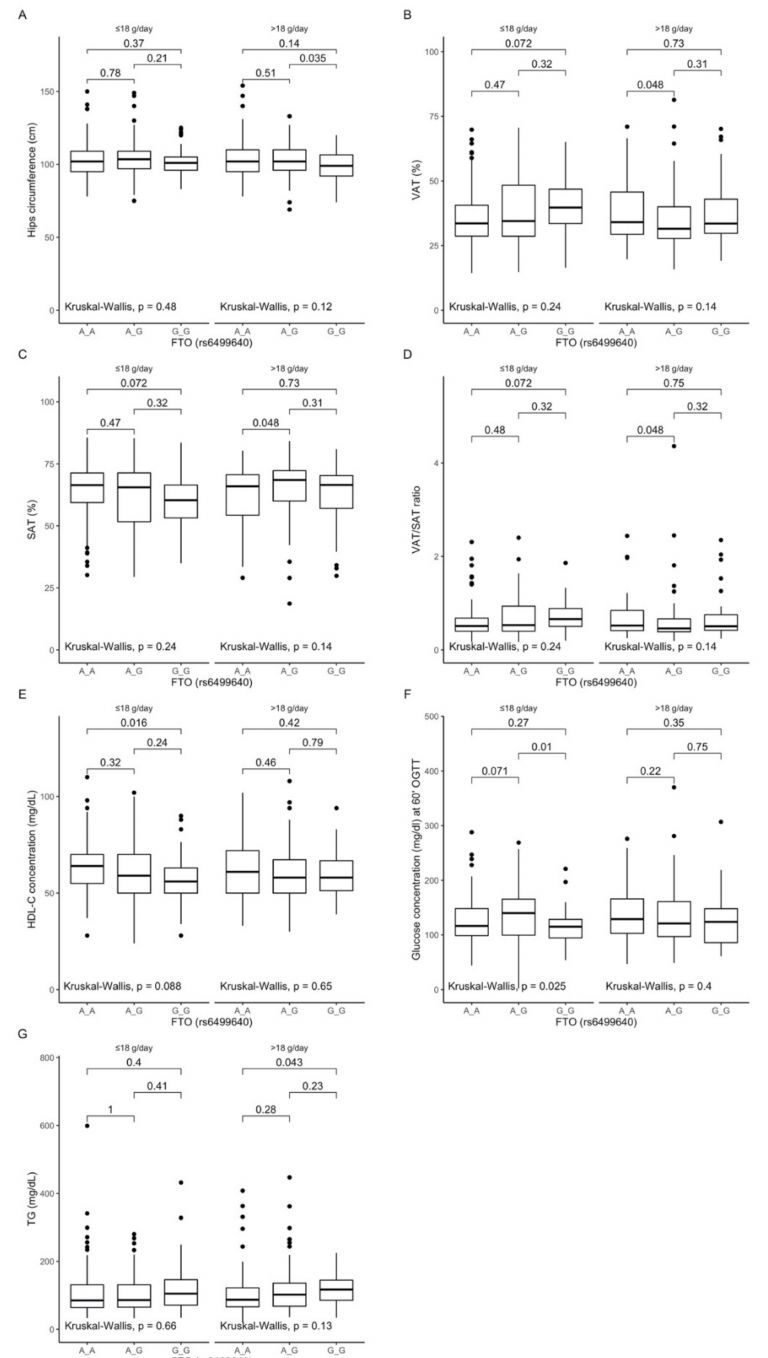
Figure 3. Association of the FTO rs6499640 genotypes with ( A ) Hip circumference (cm); ( B ) Vis- ceral adipose tissue (VAT) (cm 3 ); ( C ) Subcutaneous adipose tissue (SAT) (%); ( D ) VAT/SAT ratio; ( E ) HDL-C concentration (mg/dL); ( F ) Glucose concentration (mg/dL) at 60 min of OGTT; ( G ) Triglycerides (TG) (mg/dL) by dietary fiber intake strata: ≤ 18 g/day and >18